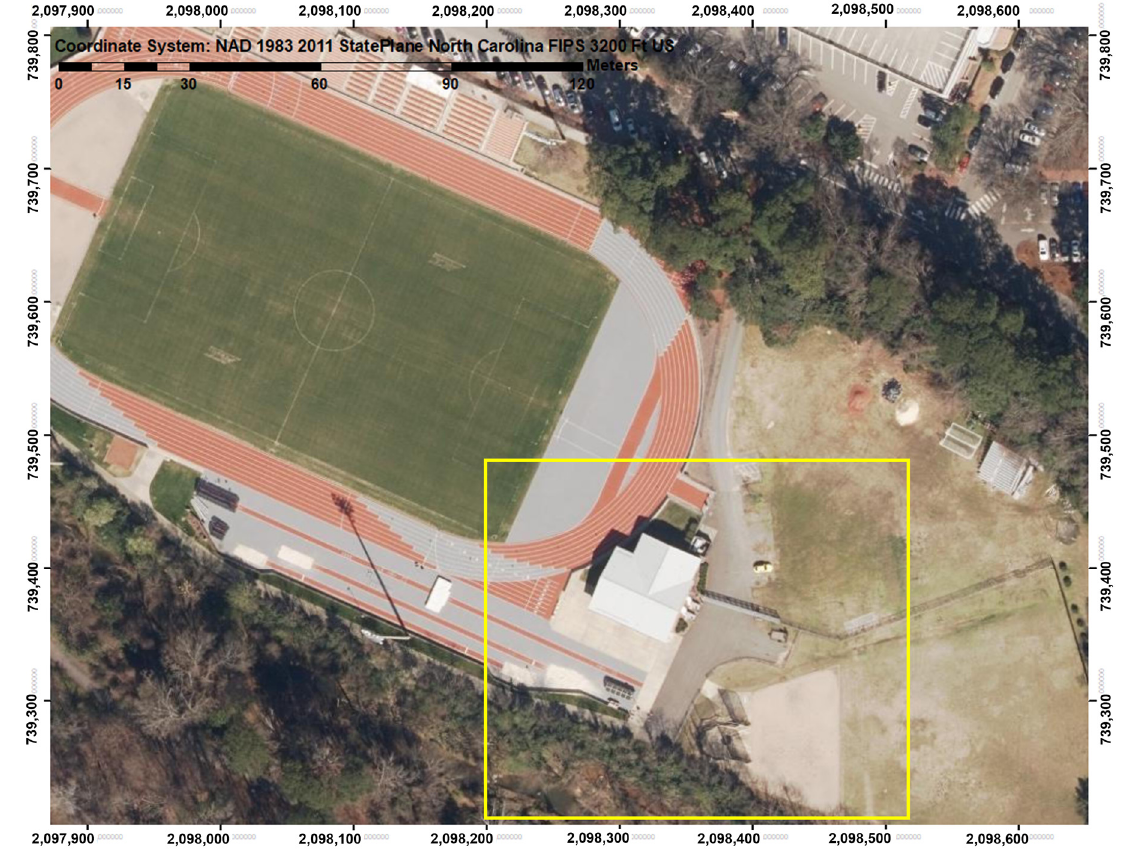
Figure 2. Study Site